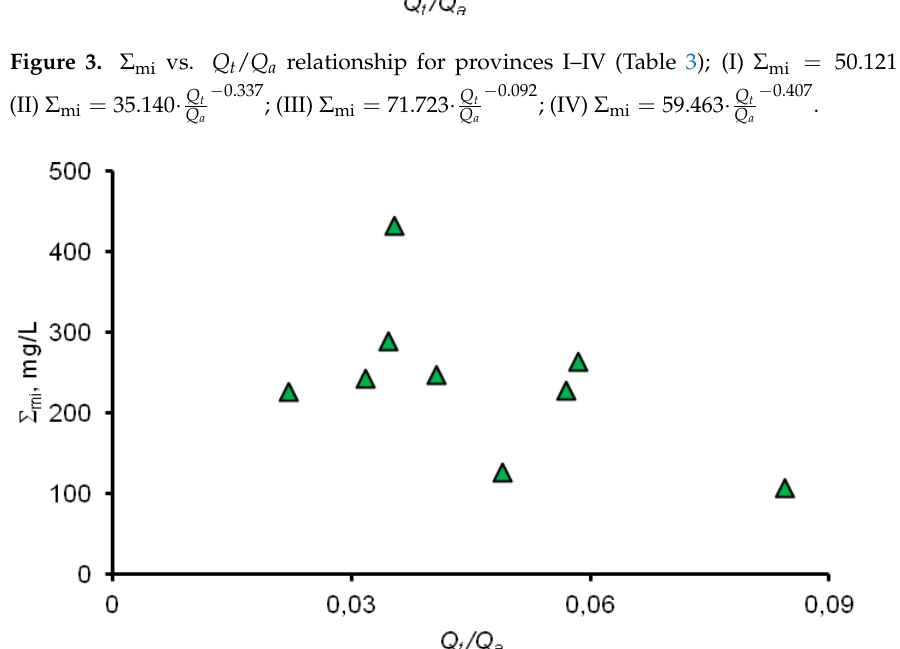
Figure 3. Σ mi vs. Q t / Q a relationship for provinces I–IV (Table 3); (I) Σ mi = 50.121 · Q t (II) Σ mi = 35.140 · Q t